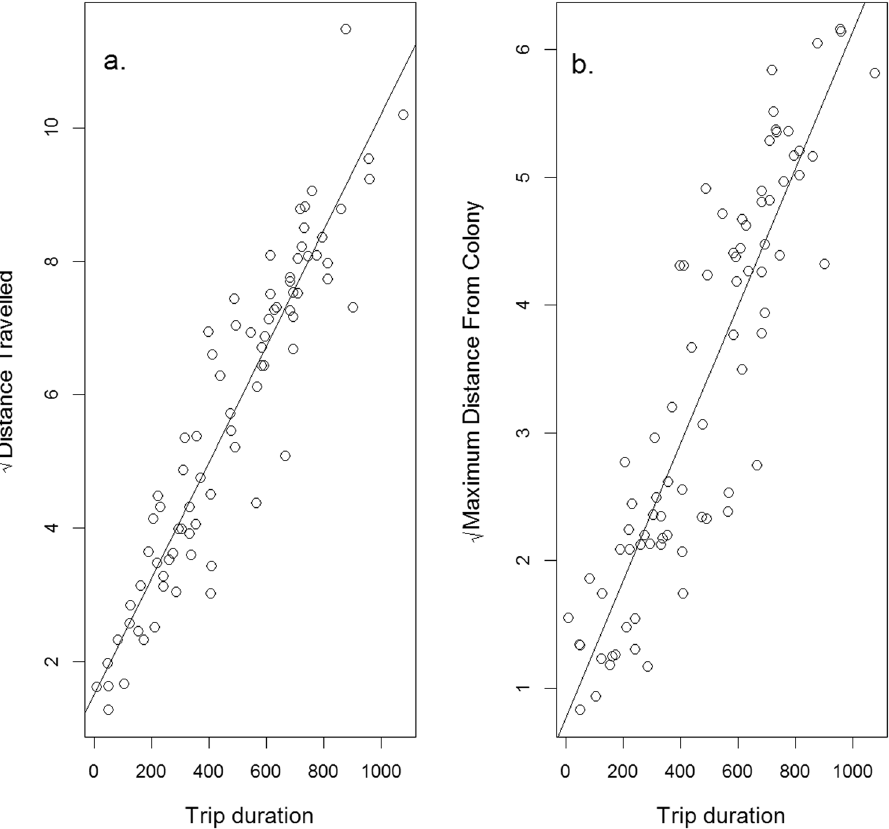
Figure 1. The relationship between ( a ) the square root of the total distance travelled during a trip (km) and ( b ) the square root of the maximum distance reached from the colony (km) in relation to the trip duration (mins). Distance travelled (D) increased with trip duration (t) according to the equation: D = 1.52 + 0.009 √ t, while maximum distance from the colony (M) increased with trip duration according to the equation: M = 0.77 + 0.005 √ t. The relationships are highly significant (distance travelled: F = 544.9, df = 1, P < 0.0001; maximum distance: F = 342.1, df = 1, P <